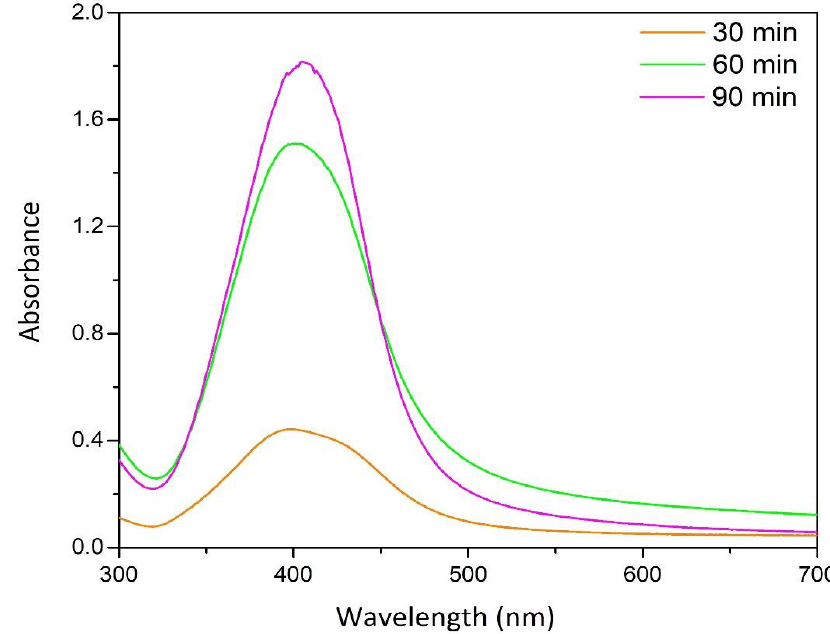
Figure 3. The effect of UV irradiation time on AgNP synthesis. Figure 2. The effect of UV irradiation time on AgNP synthesis.